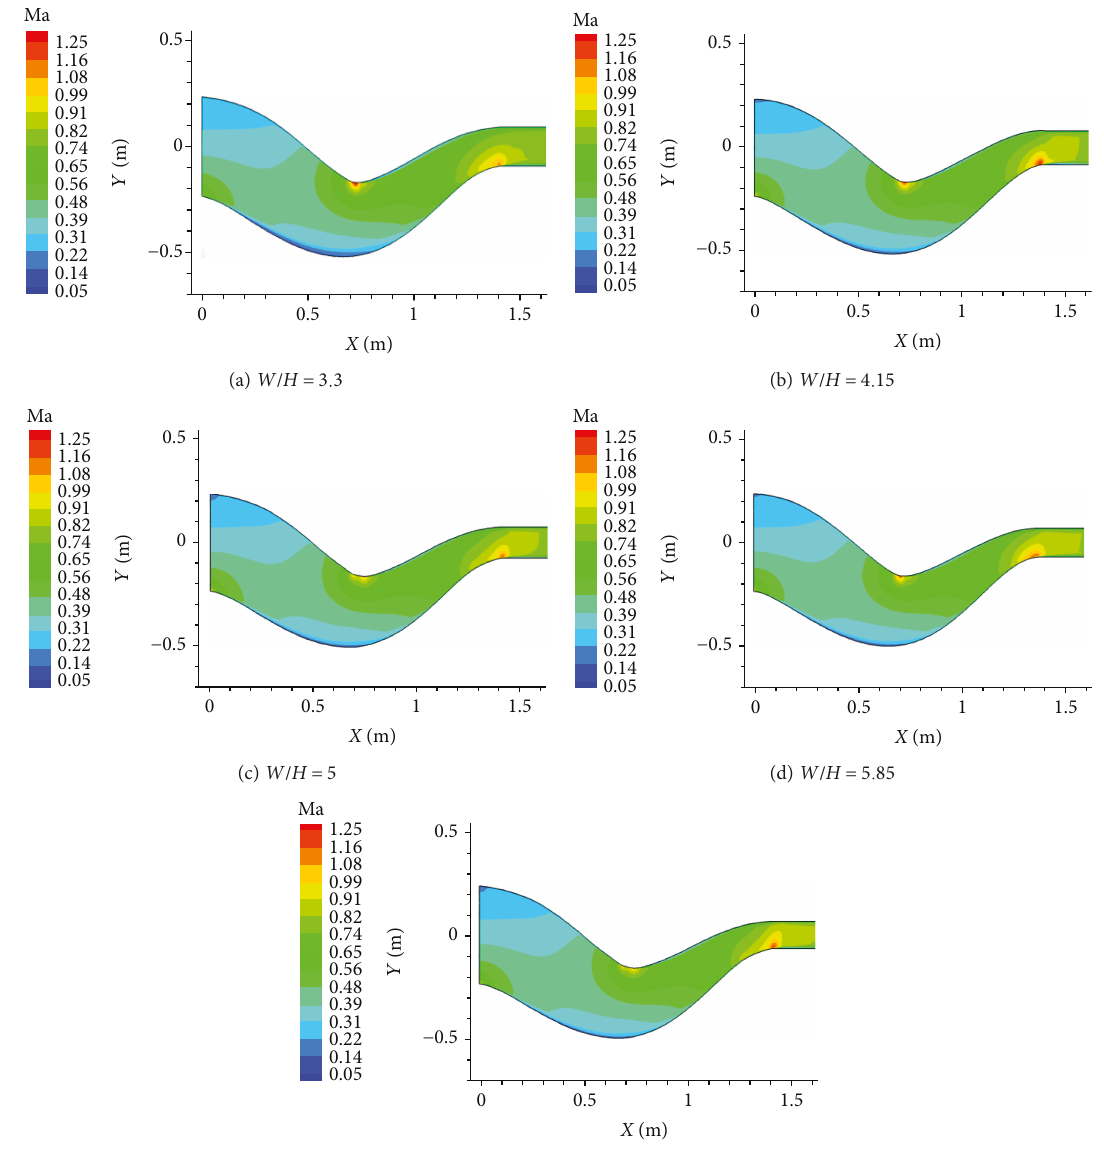
Figure 16: Mach number distributions on symmetric plane ( L / D = 3 5 , S / D = 0